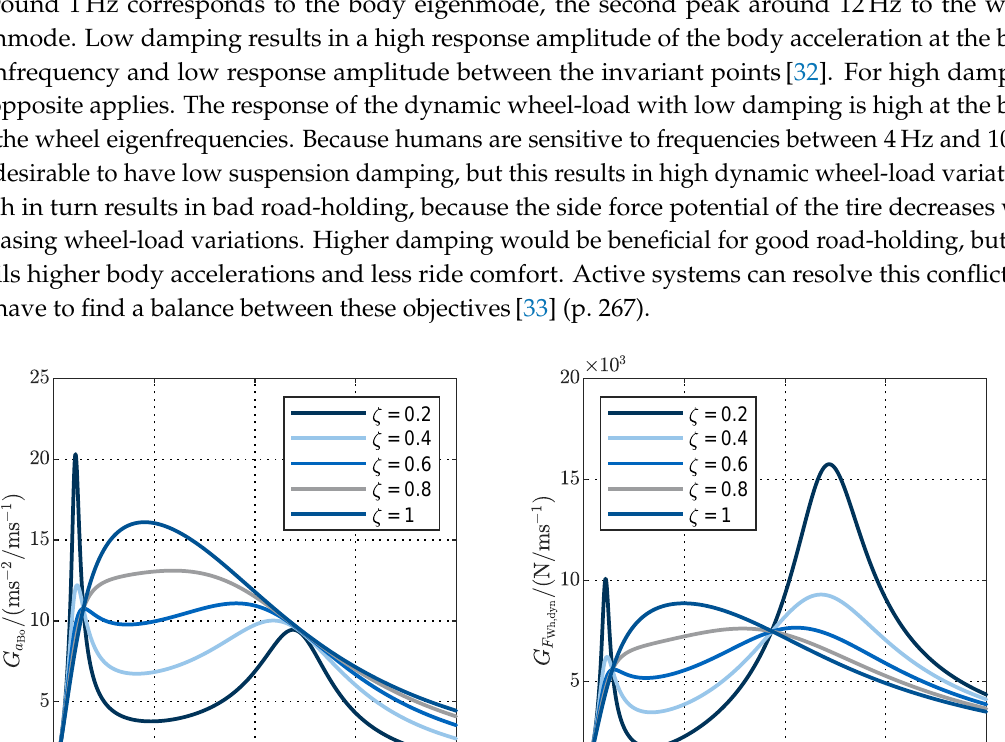
on the ( left ), dynamic wheel-load gain G F Bo